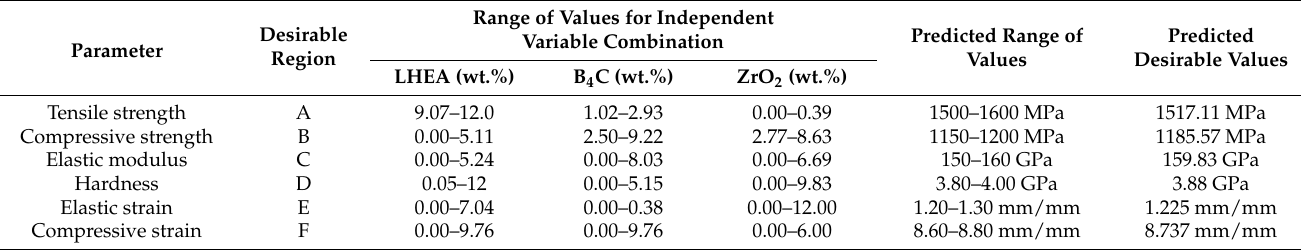
Table 4. Parametric range for desirable